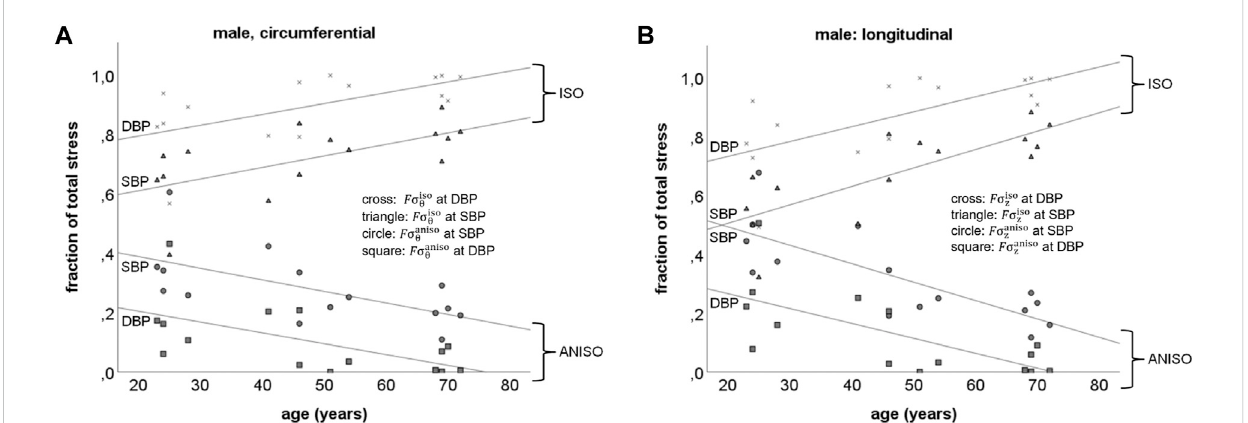
FIGURE 5 Schematic representation of the load bearing fractions of material with isotropic and anisotropic properties in the abdominal aorta at systolic (SBP) and diastolic (DBP) blood pressures in males, in the circumferential (A: F σ iso θ ; F σ aniso θ ) and in the longitudinal (B: F σ iso z ; F σ aniso z ) direction (A) DBP : F σ iso θ R 2 = 0.36, p < 0.05; F σ aniso θ R 2 =0.36, p < 0.05; SBP ; F σ iso θ R 2 =0.38, p < 0.05; F σ aniso θ R 2 =0.38, p < 0.05 (B)DBP : F σ iso z R 2 =0.46, p < 0.01and F σ aniso